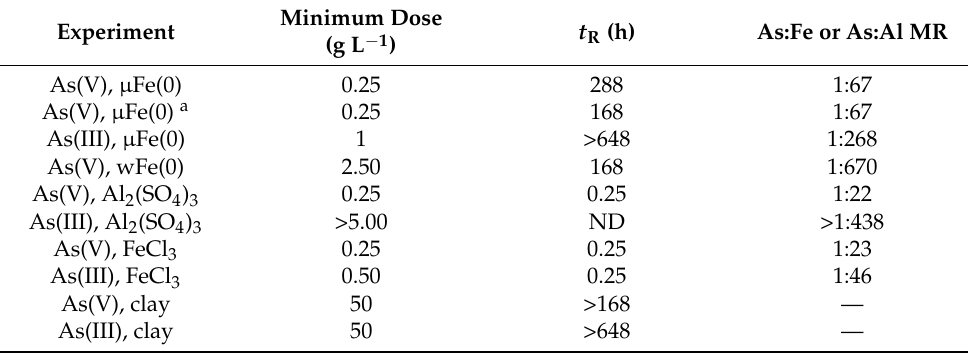
Table 4. Comparison between the different technologies studied for the removal of As(V) and As(III) from synthetic solutions. Conditions: [As(V)] or [As(III)] = 5 mg L − 1 , pH 7 (constant), RT, EC = 0.03 mS cm − 1 .